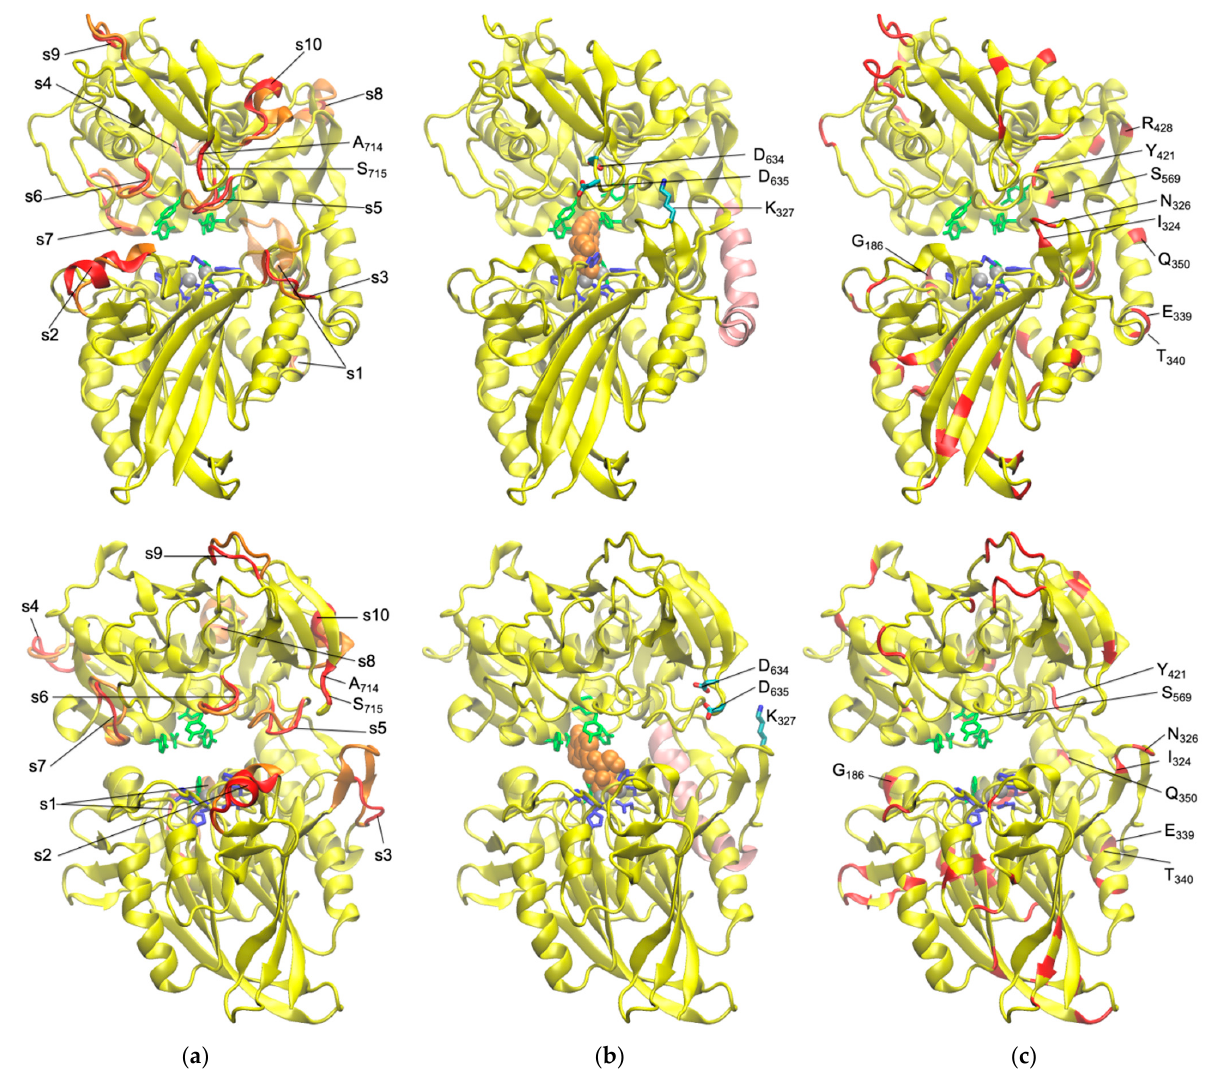
Figure 4. Molecular models of the CpdB-like proteins of ( a ) S. suis, ( b ) S. enterica and ( c ) E. coli . The three structures correspond to the parts of the proteins that were used for enzyme characterization (as indicated in Figure 3). They contain the 5_nucleotid_C domain, the interdomain linker (colored pink in panel ( b )) and the metallophos domain. The upper and lower panels show the same structures with a 50° rotation. The figure shows (panel ( b )) a 3 ′ -AMP molecule in the active site of S. enterica CpdB (taken from [8]; it fits equally well in the other proteins, not shown). The dimetallic centers of the three proteins are shown ( grey spheres). The amino acid side chains configuring the substrate binding center in the 5_nucleotid_ C domain (colored in green ), and those coordinated to the metal ions in the metallophos domain (colored in blue ) are all sequentially and spatially conserved in the three proteins. In the SntA structure ( a ), parts colored in red (except A 714 –S 715 ) are those showing differences of structure with respect to CpdB (marked also in Figure 3), and those colored in orange depict the parts of CpdB which are substituted in SntA. In the E. coli CpdB structure ( c ), parts colored in red indicate differences of sequence with respect to S. enterica CpdB (marked also in Figure 3). For comments on s1–s10 and other labels, see the text of Section 2.3.